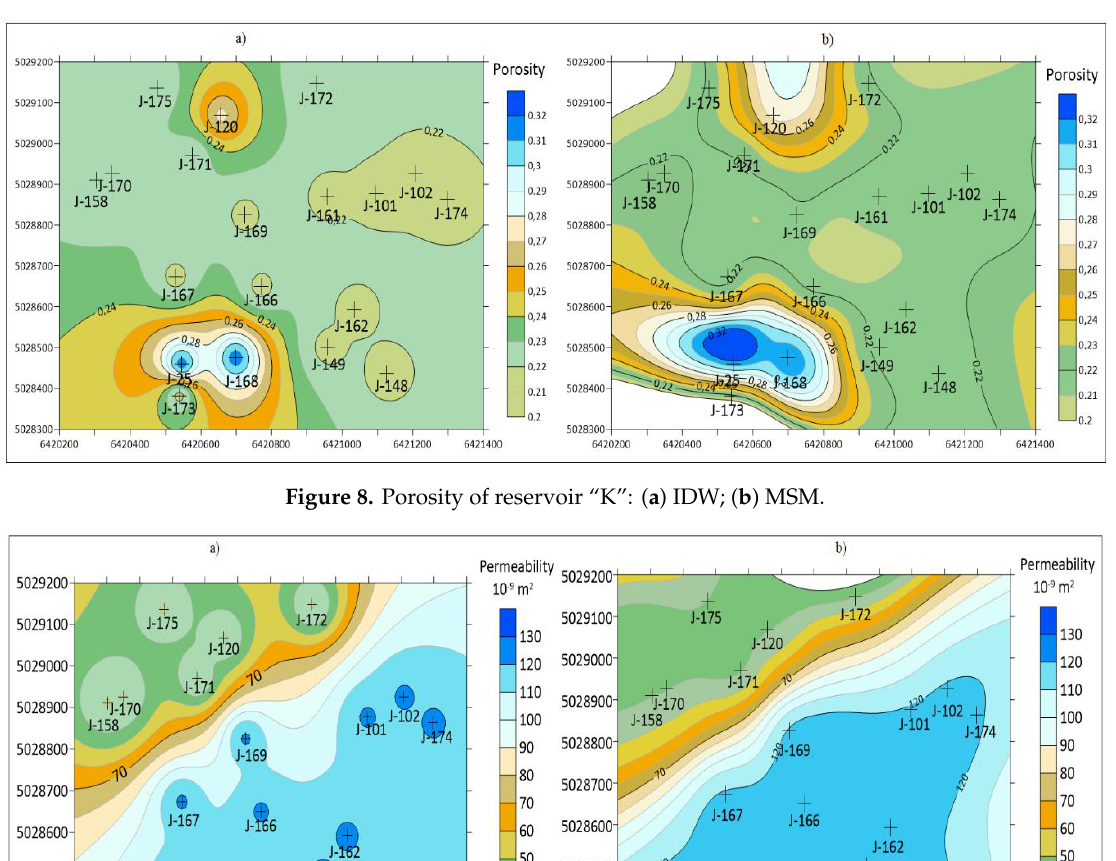
Figure 9. Permeability of reservoir “K”: ( a ) IDW; ( b ) MSM.